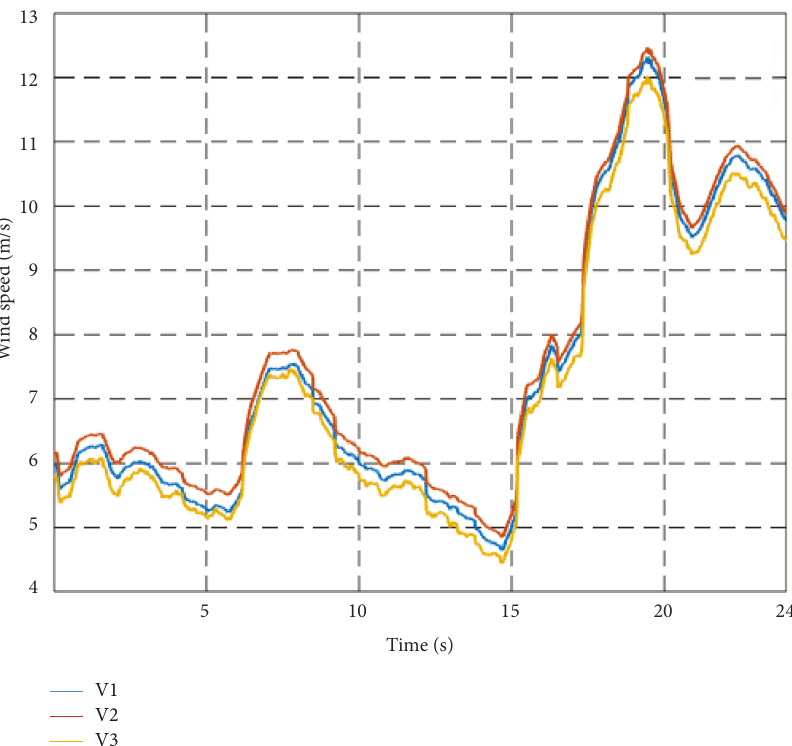
Figure 17: Wind speed